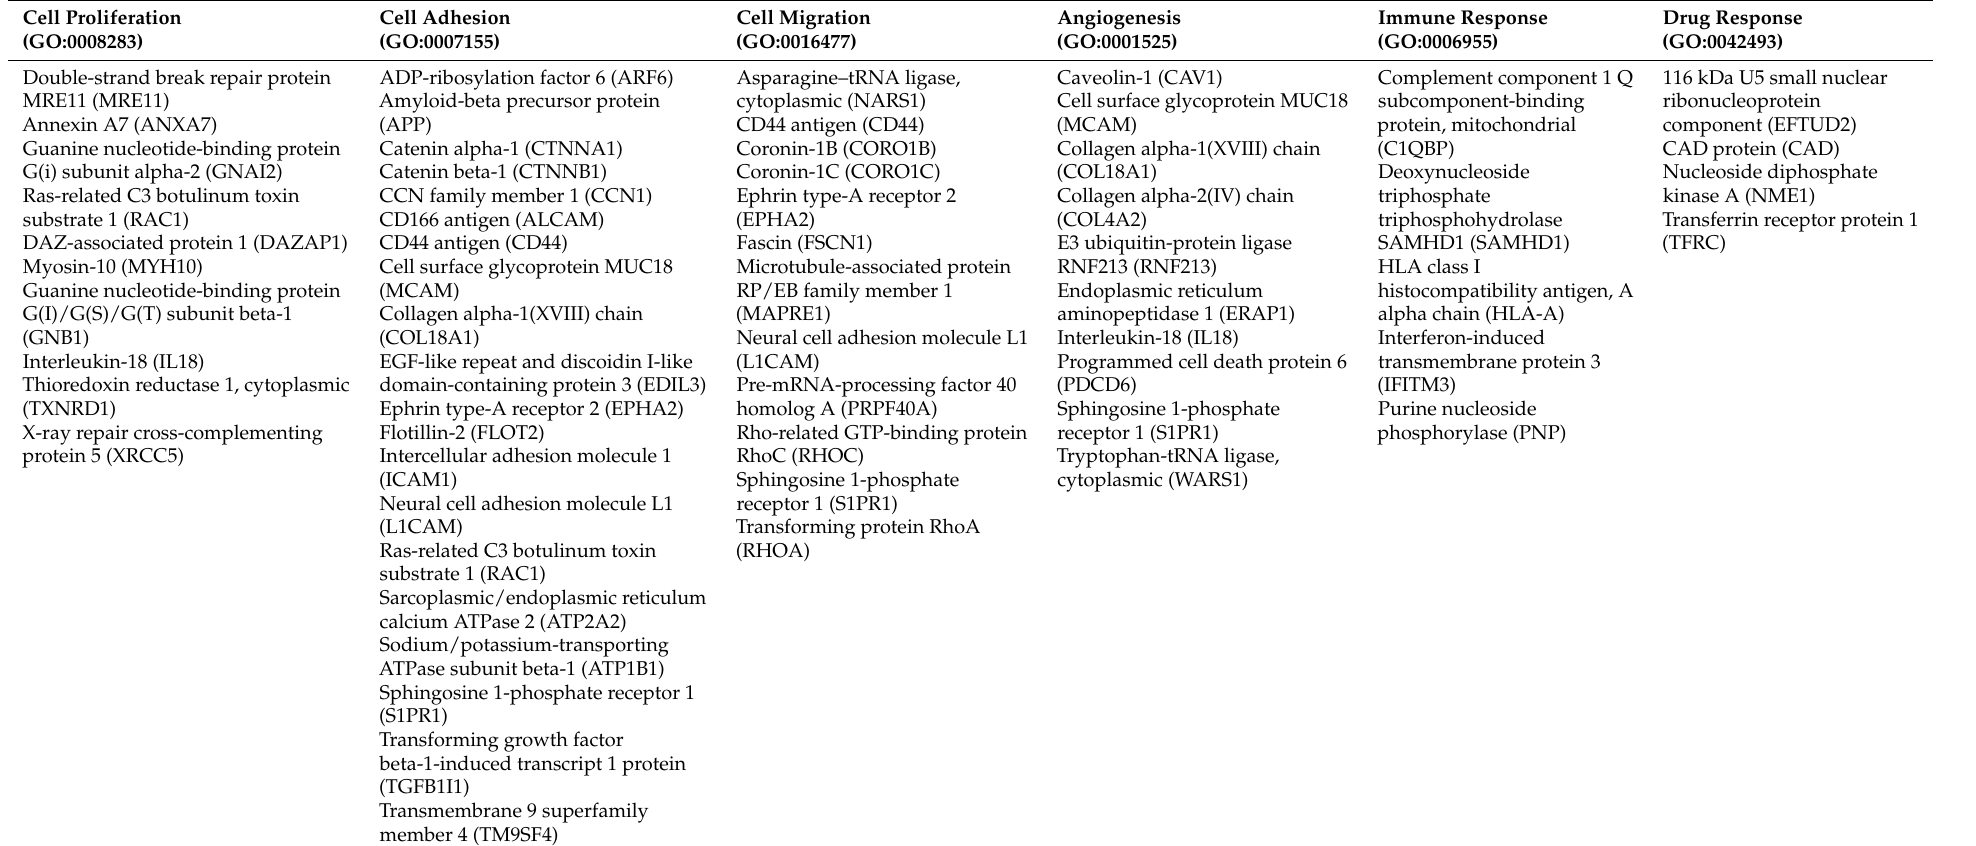
Table 1. Functional classification of cancer-related proteins identified in ectosomes derived from T-24 urothelial bladder carcinoma